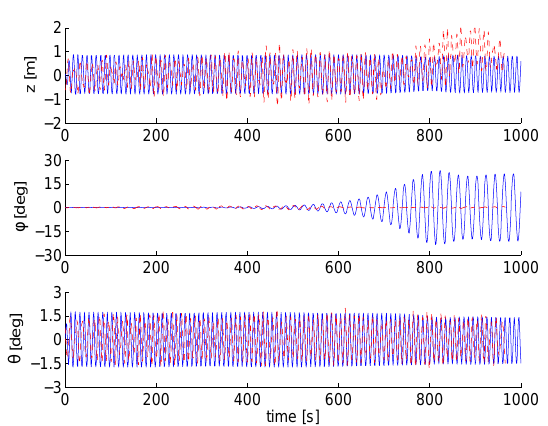
Figure 19: Exp. 1189. Exp. dashed red, sim. solid blue.